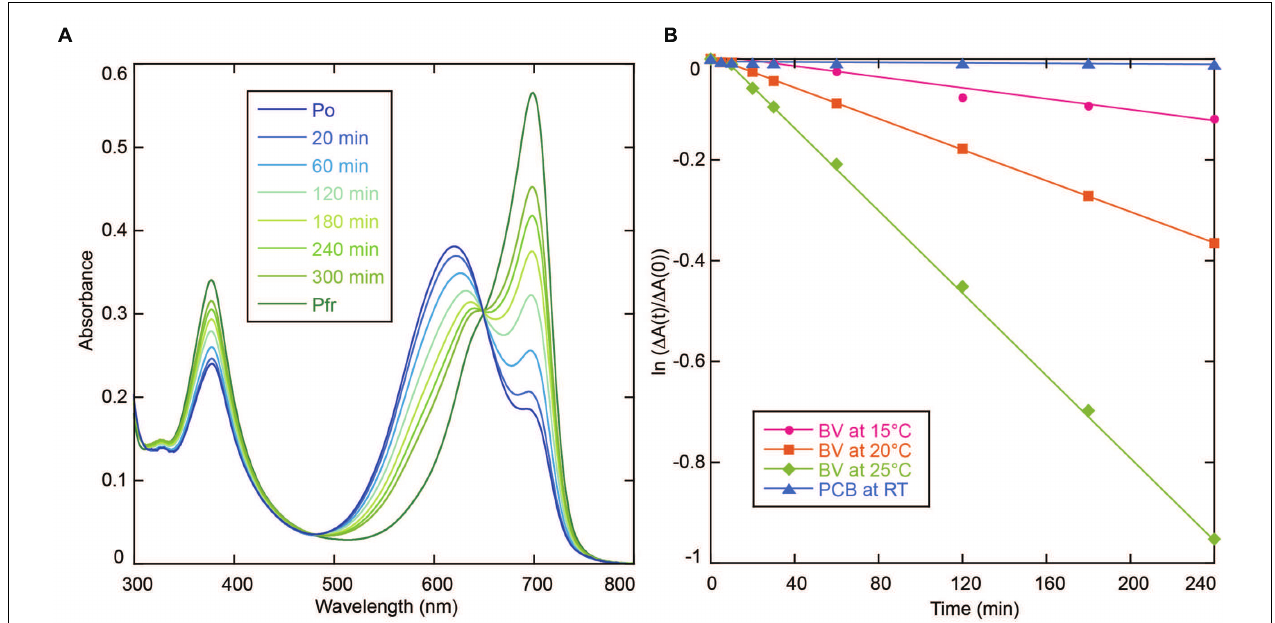
FIGURE 3 | (A) Absorption spectra of AM1_C0023g2-BV recorded during dark reversion at 25 ◦ C. (B) Dark reversion kinetics of PCB- (blue triangle for room temperature) and BV-binding (magenta circle for 15 ◦ C, orange square for 20 ◦ C and green diamond for 25 ◦ C) AM1_C0023g2 from metastable Pg and Po forms to thermostable Pr and Pfr forms,